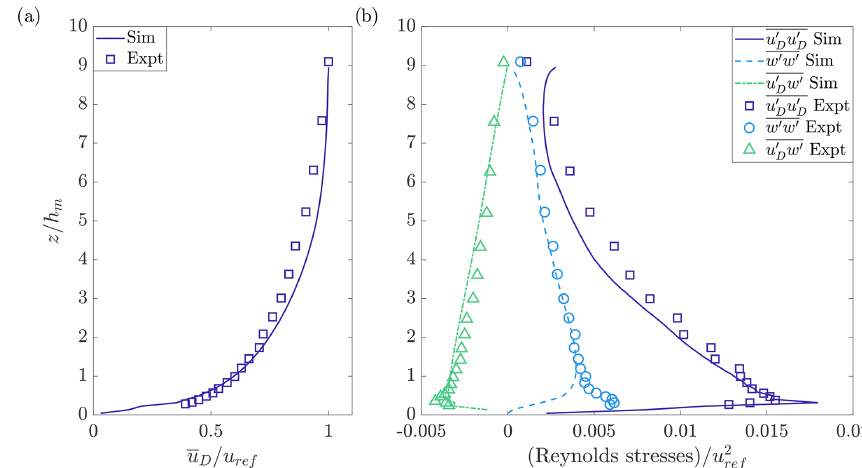
Figure 8. Horizontally averaged (a) mean velocity and (b) Reynolds stress profiles of the precursor simulation and the boundary layer developed before the urban area in the wind tunnel experiments of the DAPPLE project. Note the use of subscript D to denote alignment with the axes x D and y D (see Fig. 7). The data for these profiles were averaged for